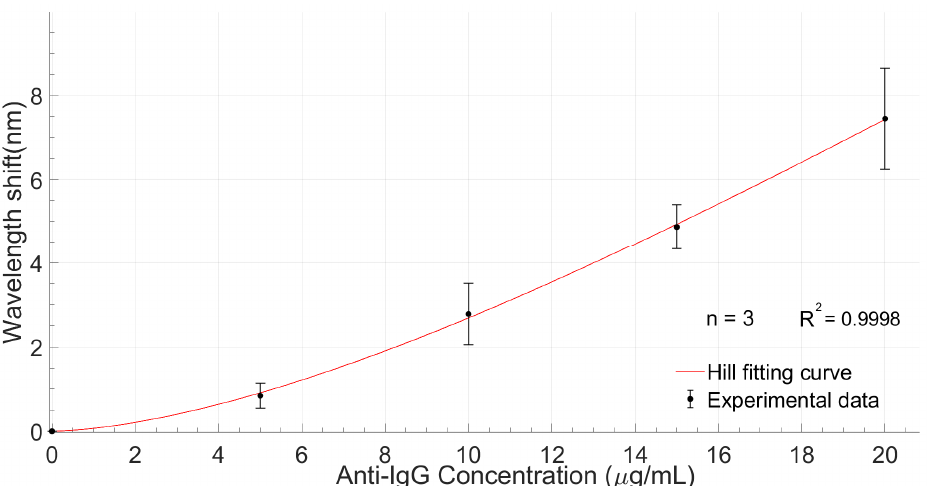
Figure 11. Calibration curve of three identical and independent biosensors (n = 3) detecting anti-IgG in PBS with the Hill fitting curve of the experimental points.